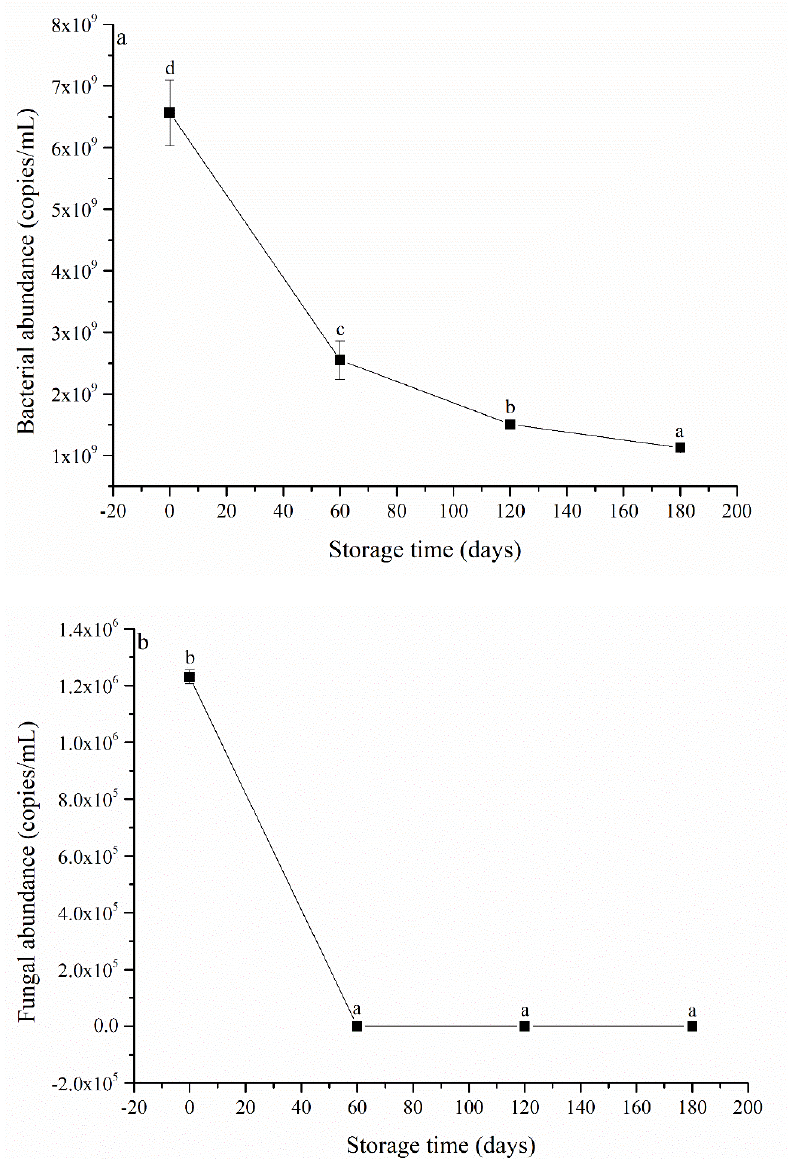
Figure 3. The bacterial ( a ); and fungal ( b ) abundances in swine wastewater at different storage times. Data shown are the means of three replicates, and different letters indicate significance at p < 0.05.